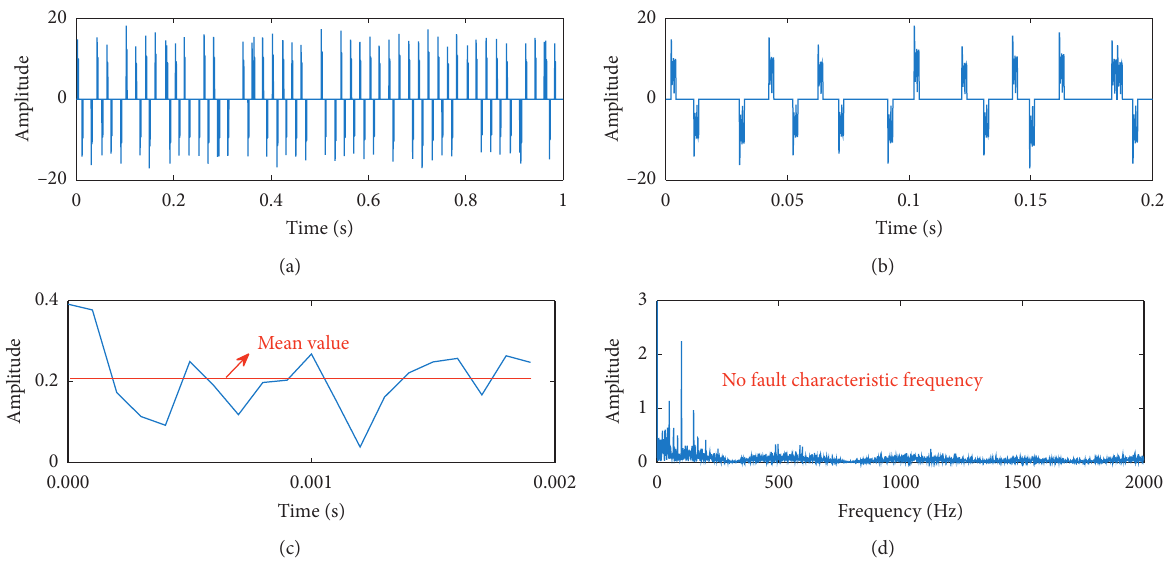
Figure 27: UC-DLA with parameters n � 20 ,k � 17 , L � 1 for identification of wheelset bearing outer race fault. (a) Sparse reconstruction signal; (b) locally zoomed figure of the impulses shown in Figure 27(a); (c) learned shock responses; and (d) envelope spectrum of signal in Figure 27(a).